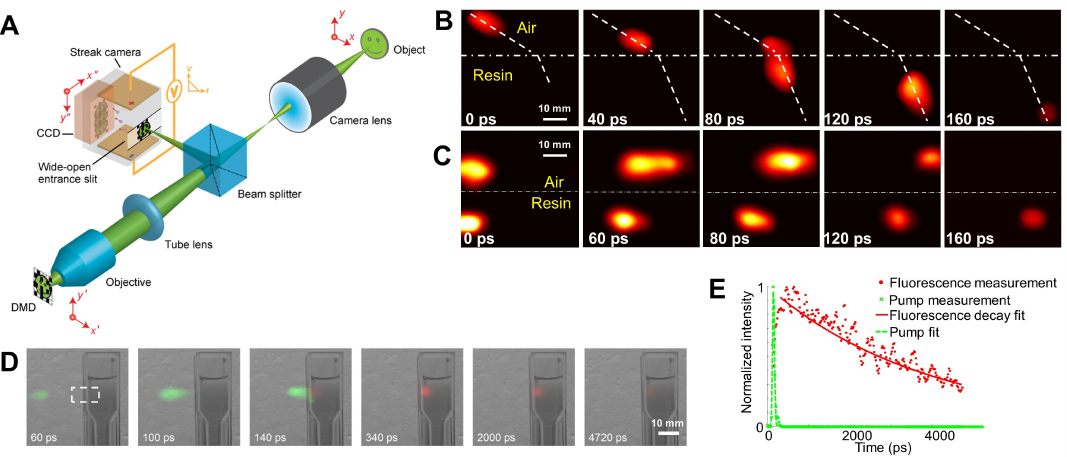
Fig. 8. CUP. (A) Schematic. (B) Imaging of light pulse refraction with CUP. (C) Imaging of the racing of two pulses with CUP. (D) Imaging of a fluorescence decay with CUP. (E) Fluorescence decay measurement with CUP. ©Figure courtesy of Ref.